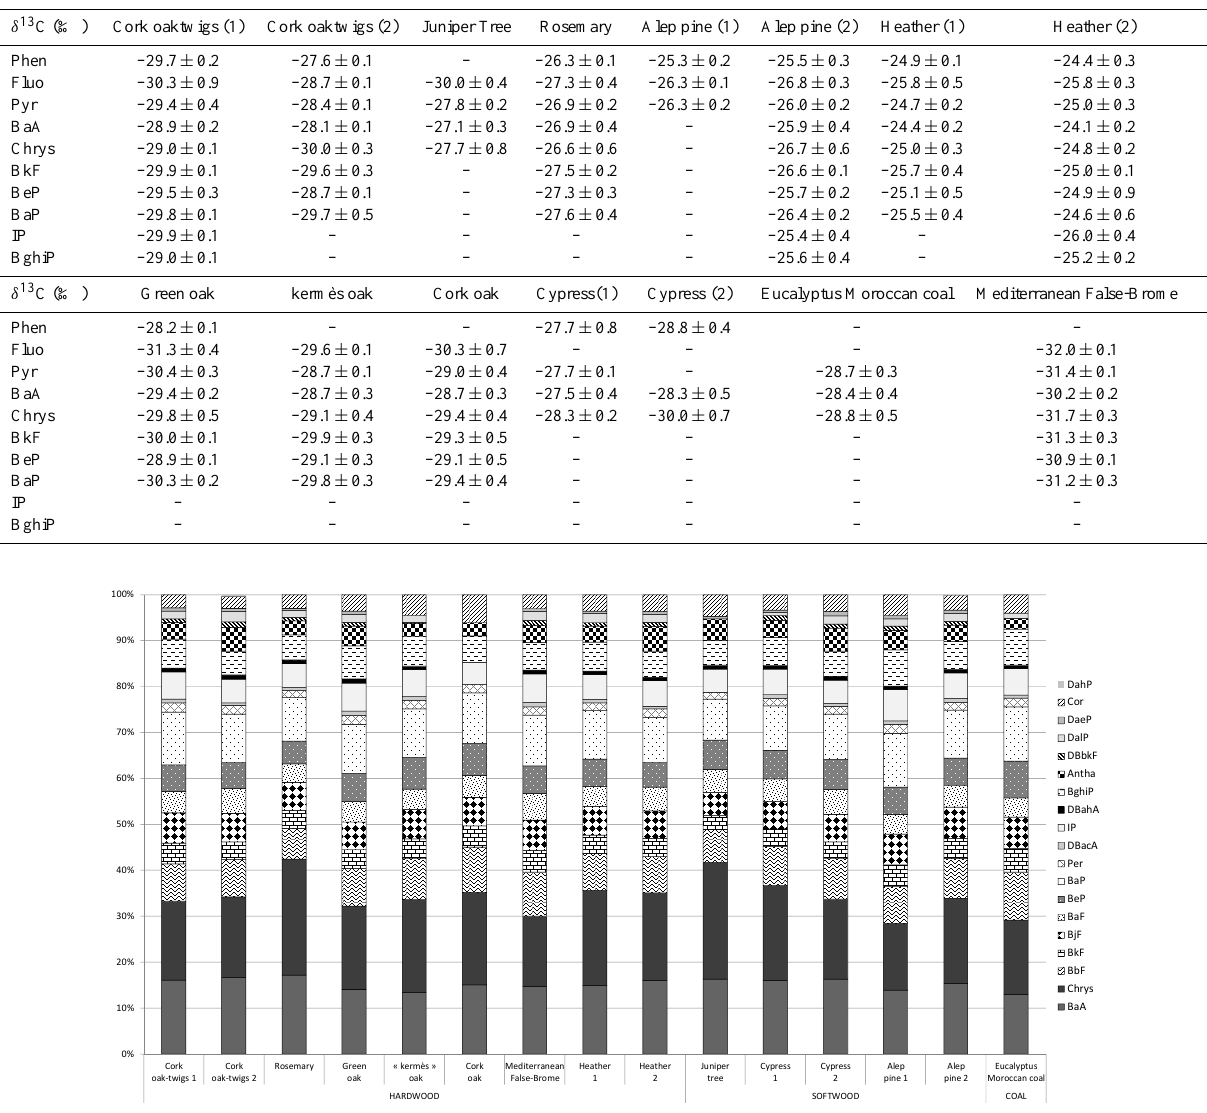
Table 7. Molecular isotopic compositions of PAHs.